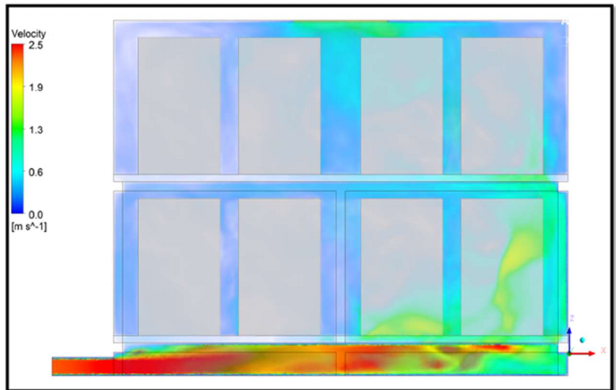
Figure 16. Air flow profile for the default model. Notice that batteries opposite the inlet receive the majority of air flow.